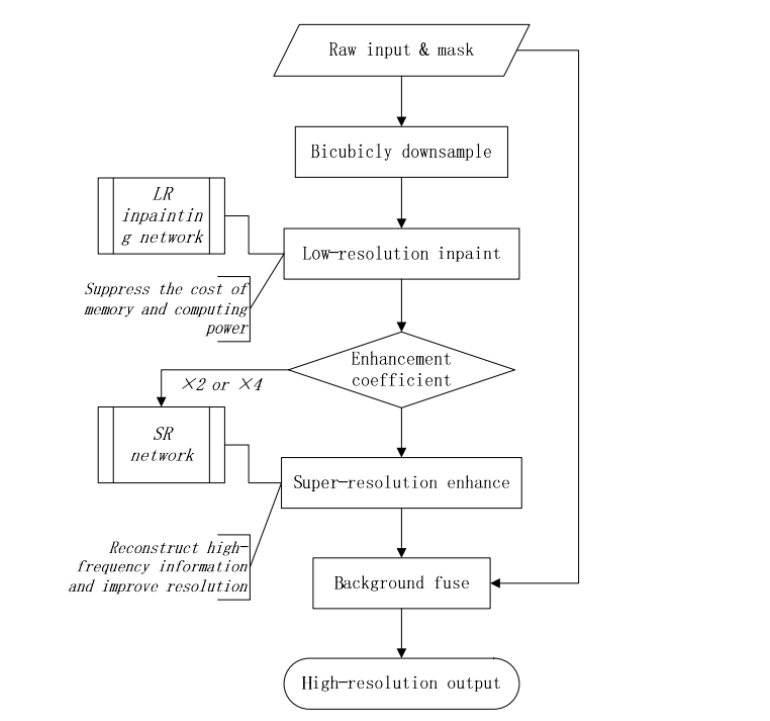
Figure 2. Algorithm flowchart of